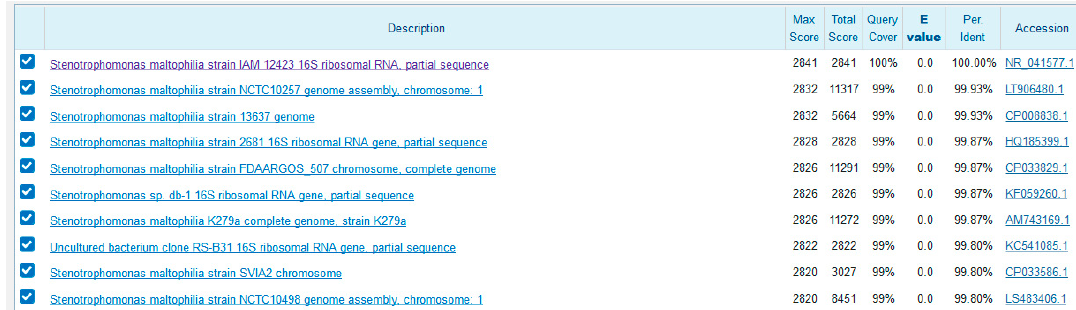
Figure 2. Nucleotide Basic Local Alignment Search Tool (BLAST) results for the isolated strain: 16a. The first ten homologues were selected for phylogenetic tree construction.